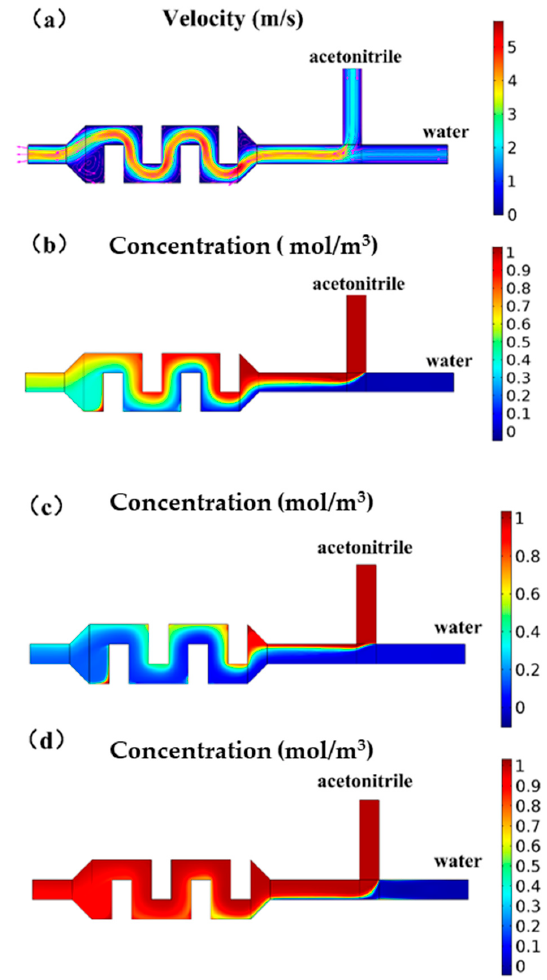
Figure 3. COMSOL simulation diagram of the chip mixing structure. ( a ) Schematic diagram of the velocity field when the inlet pressure ratio is 1:1. A vortex is formed at the inlet and outlet of the mixing channel to promote mixing. ( b ) Schematic diagram of the concentration field when the inlet pressure ratio is 1:1. ( c ) Schematic diagram of concentration field. By adjusting the pressure ratio, the concentration ratio of the mixed solution could reach 90%. ( d ) Schematic diagram of the concentration field. By adjusting the pressure ratio, the concentration ratio of the mixed solution could reach 90%.